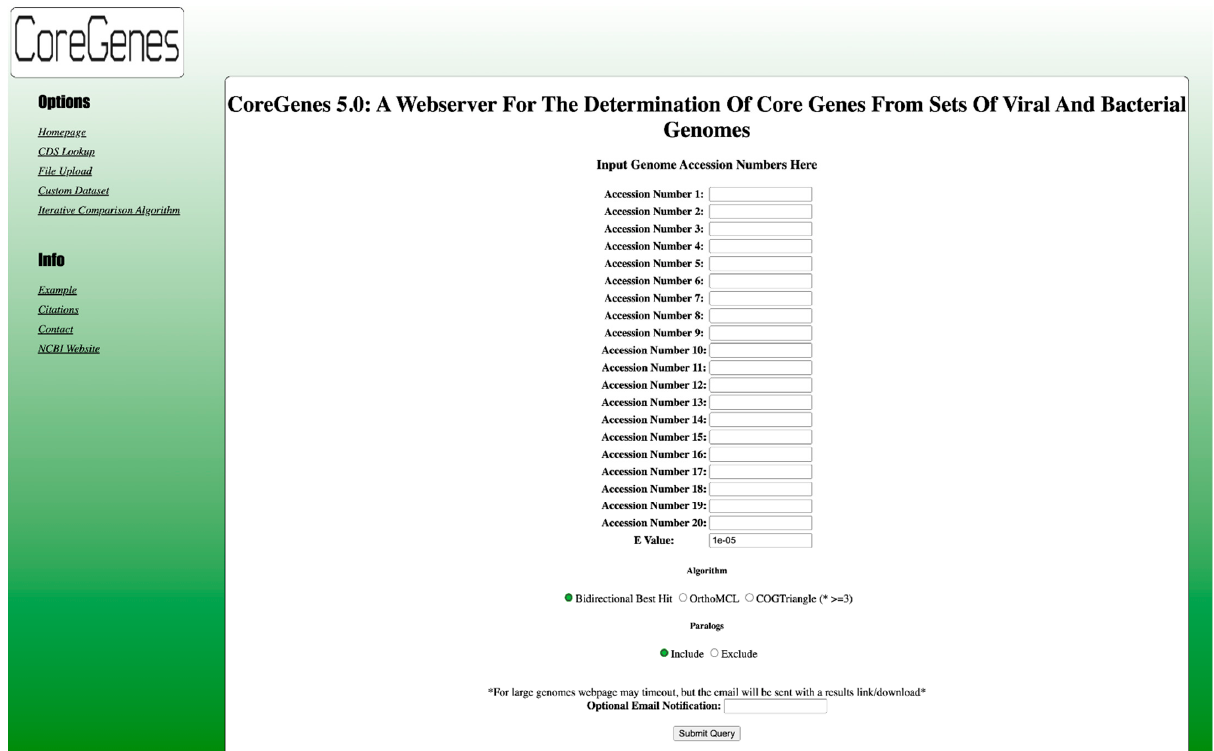
Figure 1. Web interface for CoreGenes5.0. Up to 20 accession numbers can be entered, as well as an